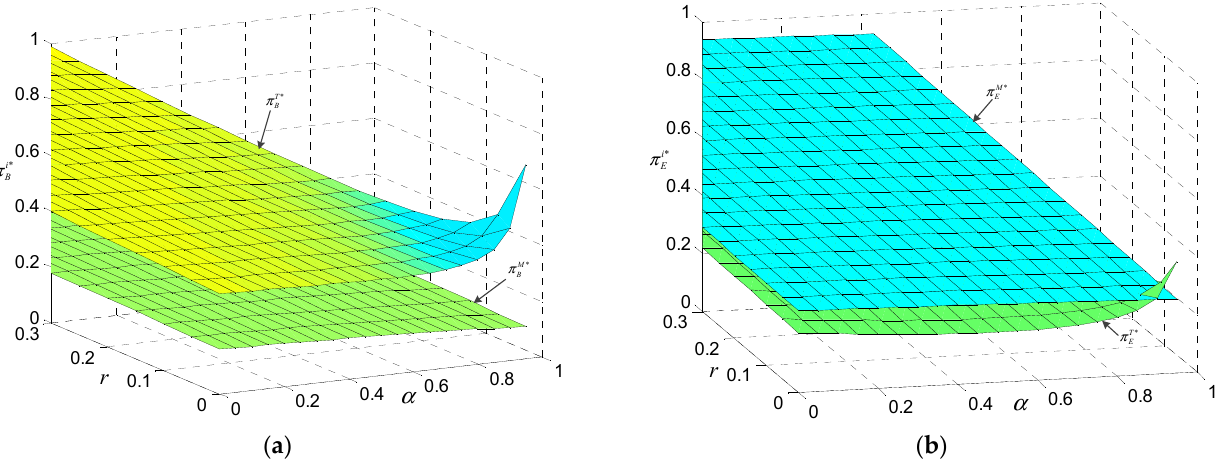
Figure 7. Impacts of remaining rate α and improvement rate r on optimal profits with two trade-in programs. ( a ) Impacts on the brand owner’s optimal profit; ( b ) Impacts on the e-commerce platform’s optimal profit.